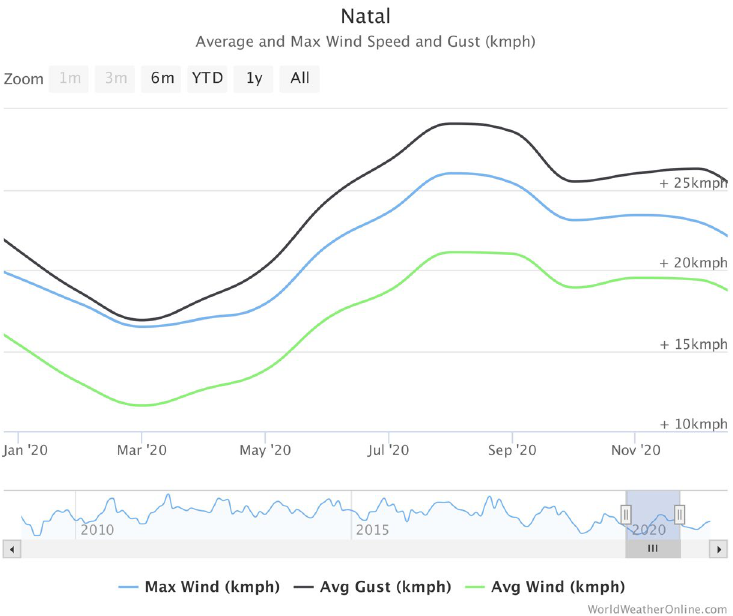
Figure 21. Max and average wind speed and wind gust during the year of 2020 for Natal,